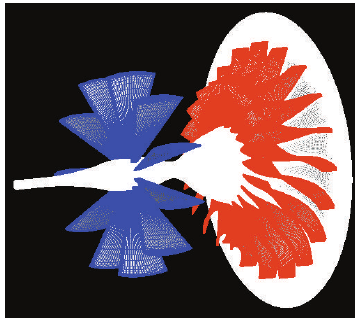
Figure 2: Mesh division of original model.